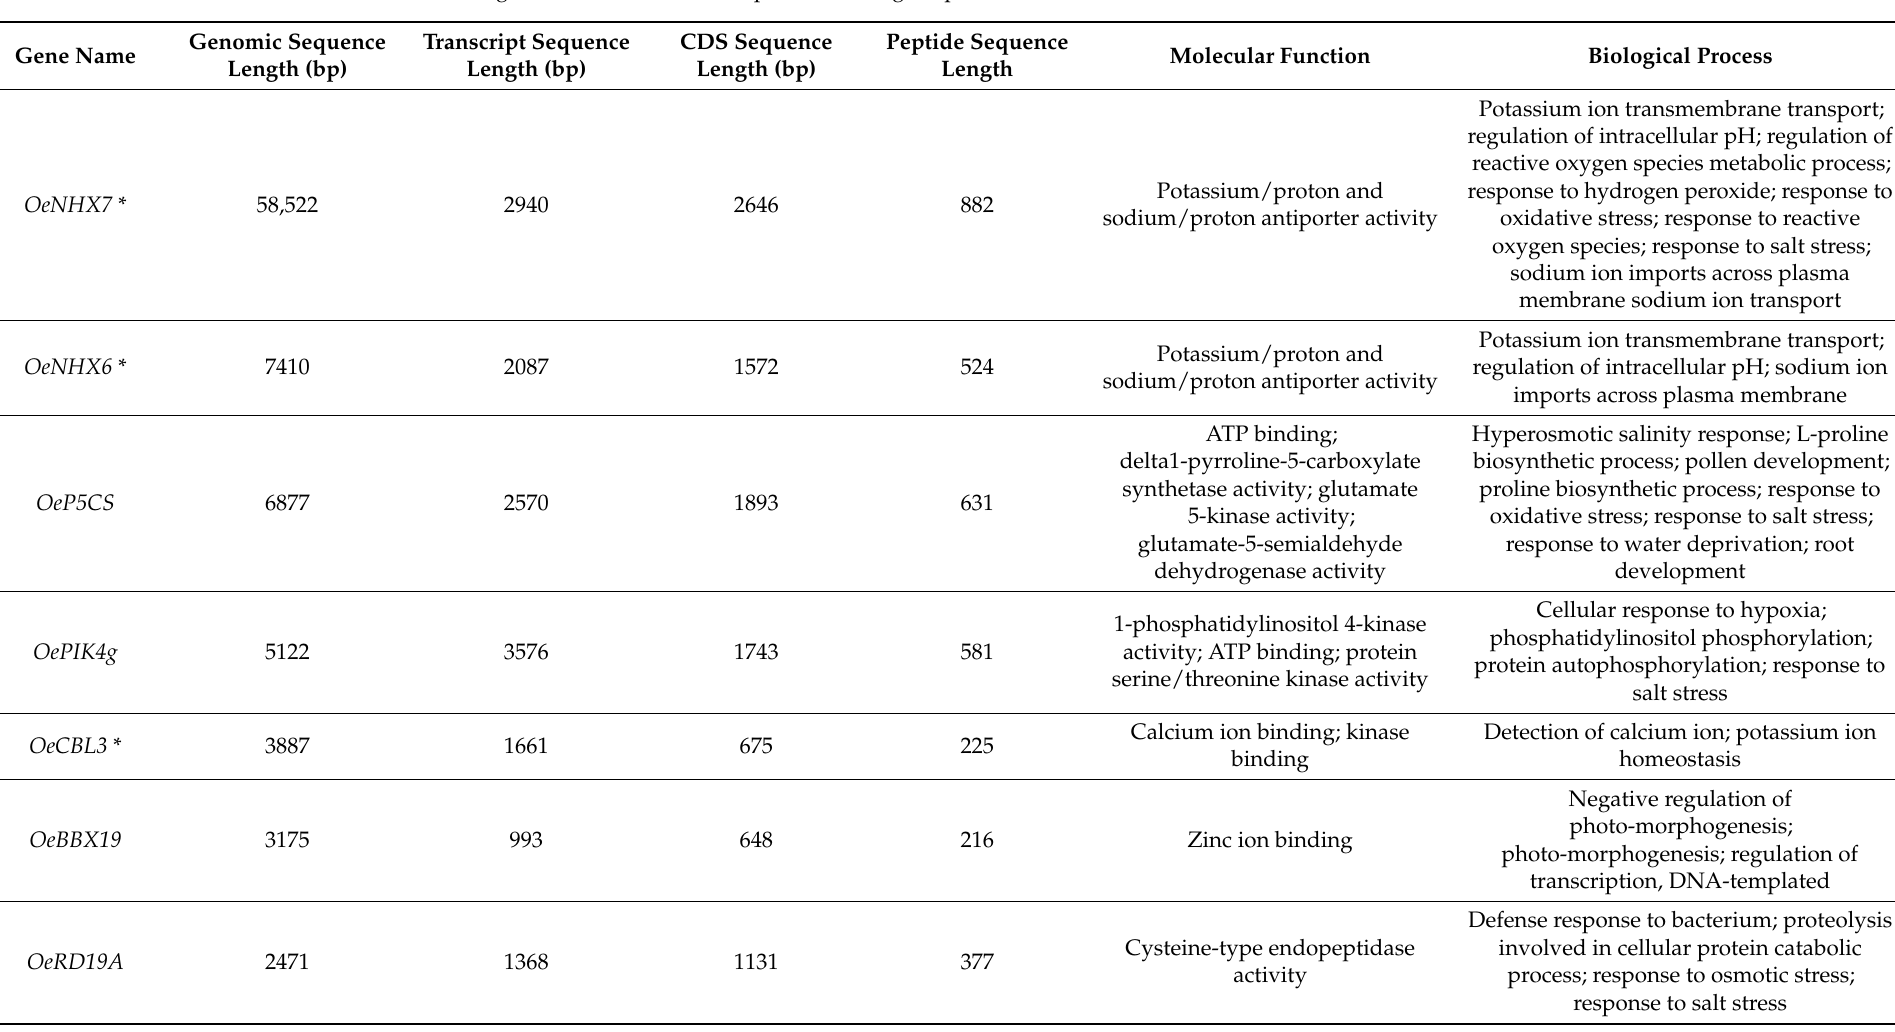
Table 2. Identified genes, their structure and putative biological